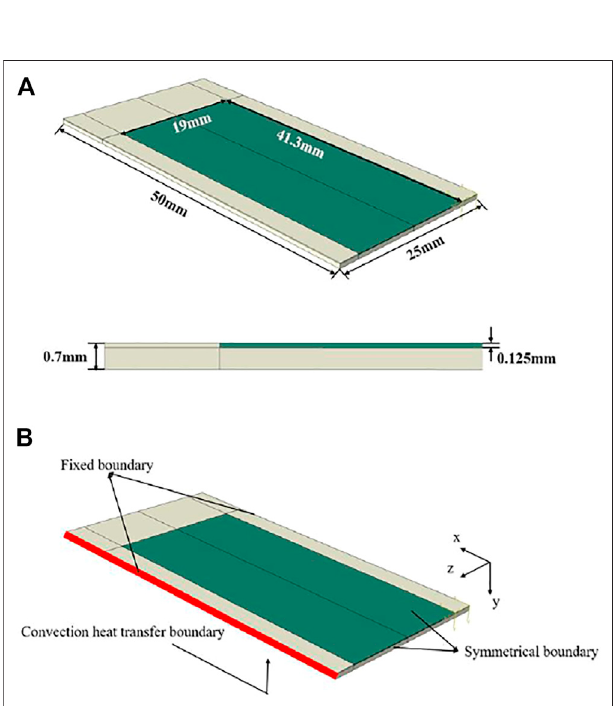
FIGURE 5 | (A) Geometry model; (B) Boundary